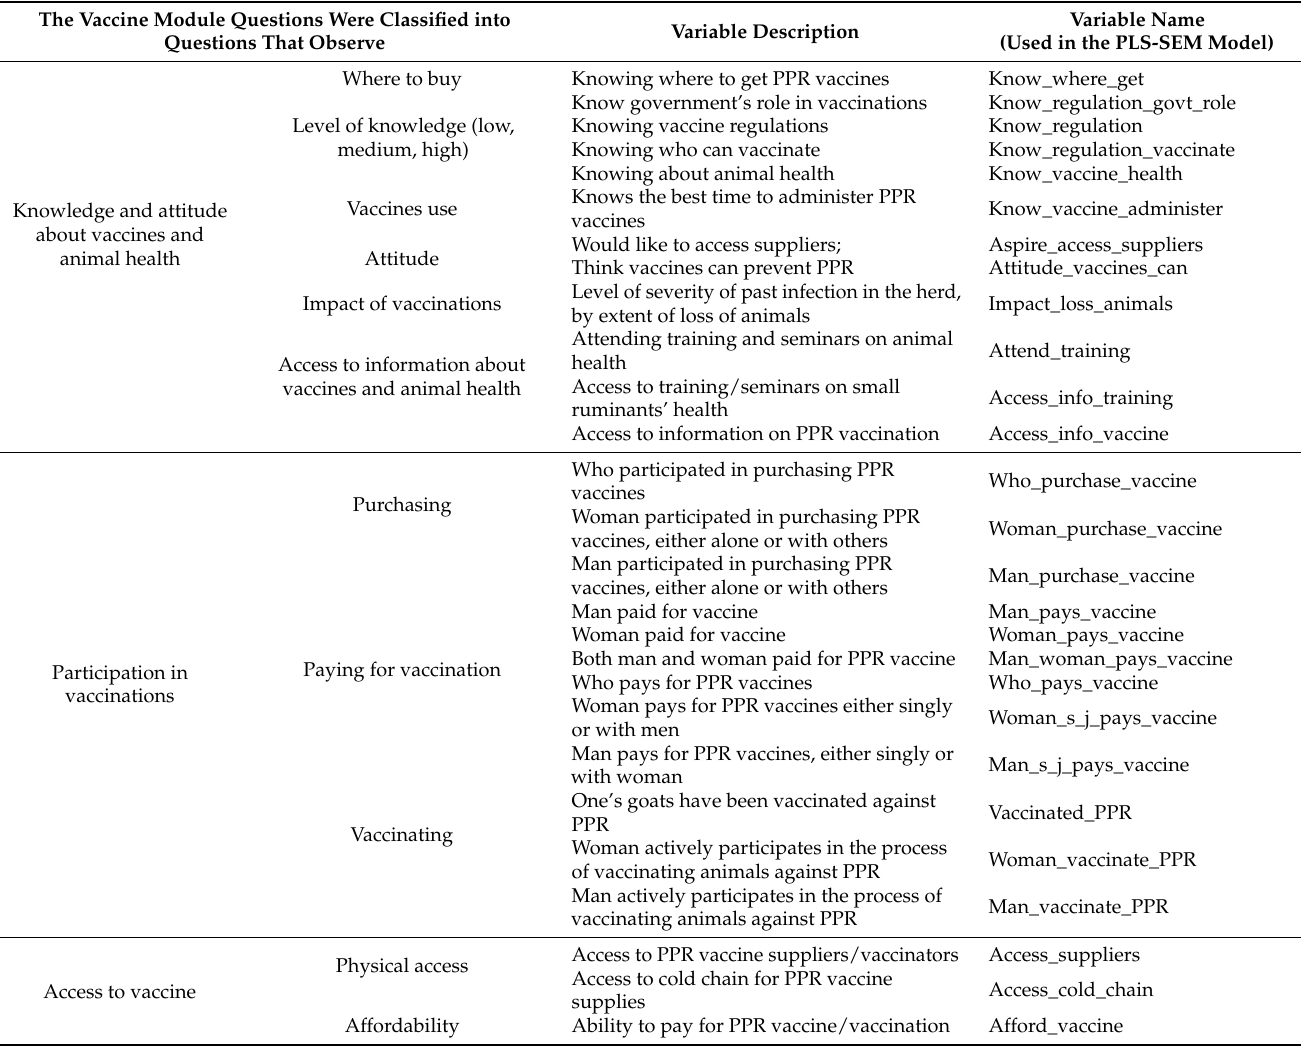
Table 1. Vaccine interventions variables from WELI Ghana